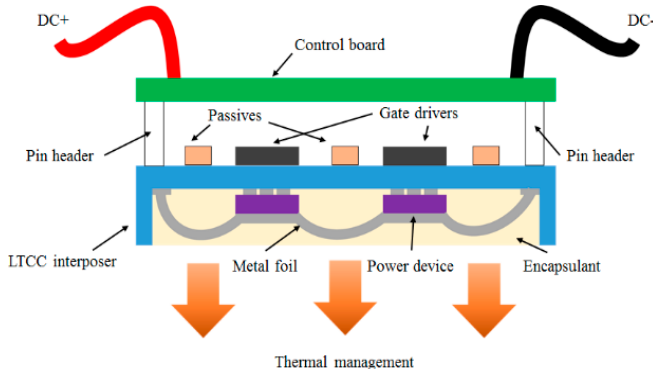
Figure 15. The LTCC based integrated wire bondless power module by Seal et al. [74].